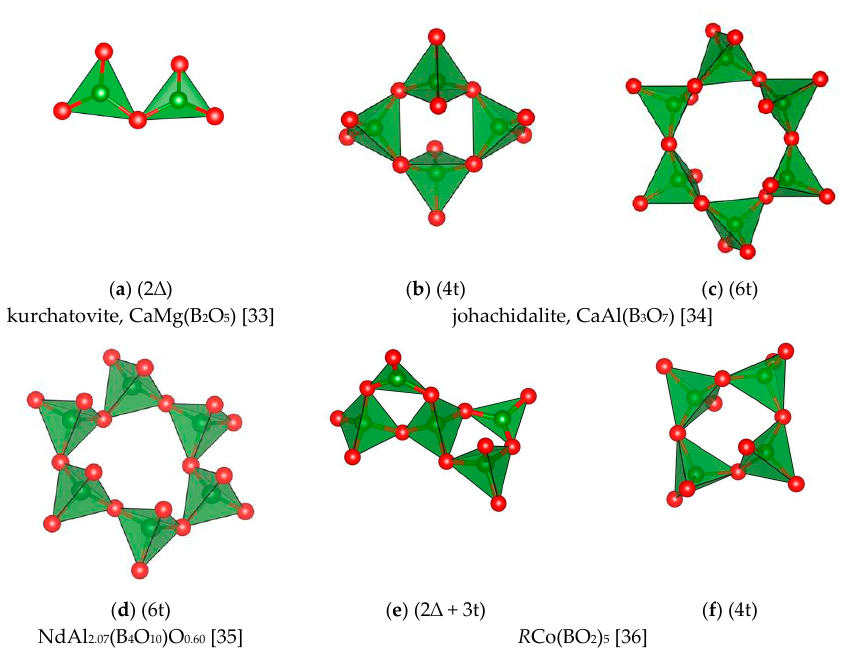
Figure 4. Examples of CSU in binary and more complex borates (the green and red balls represent B, and O atoms, respectively). ( a ) kurchatovite, CaMg(B 2 O 5 ) [33]; ( b ) and ( c ) johachidalite, CaAl(B 3 O 7 ) [34]; ( d ) NdAl 2.07 (B 4 O 10 )O 0.60 [35]; ( e ) and ( f ) R Co(BO 2 ) 5 [36].